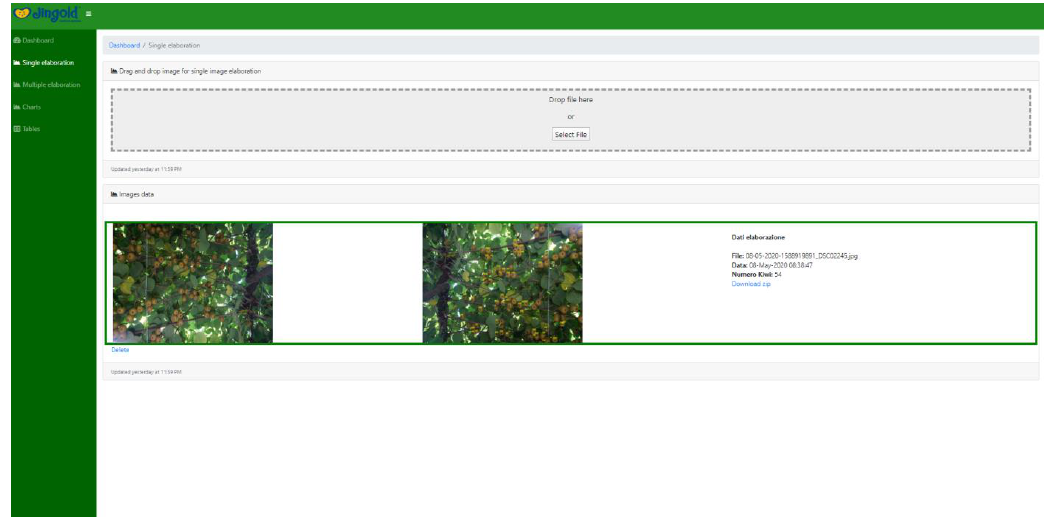
Figure 20. Web page-based kiwifruit counting instance display. ( Right ): input image. ( Left ): elaborated image and fruit count.